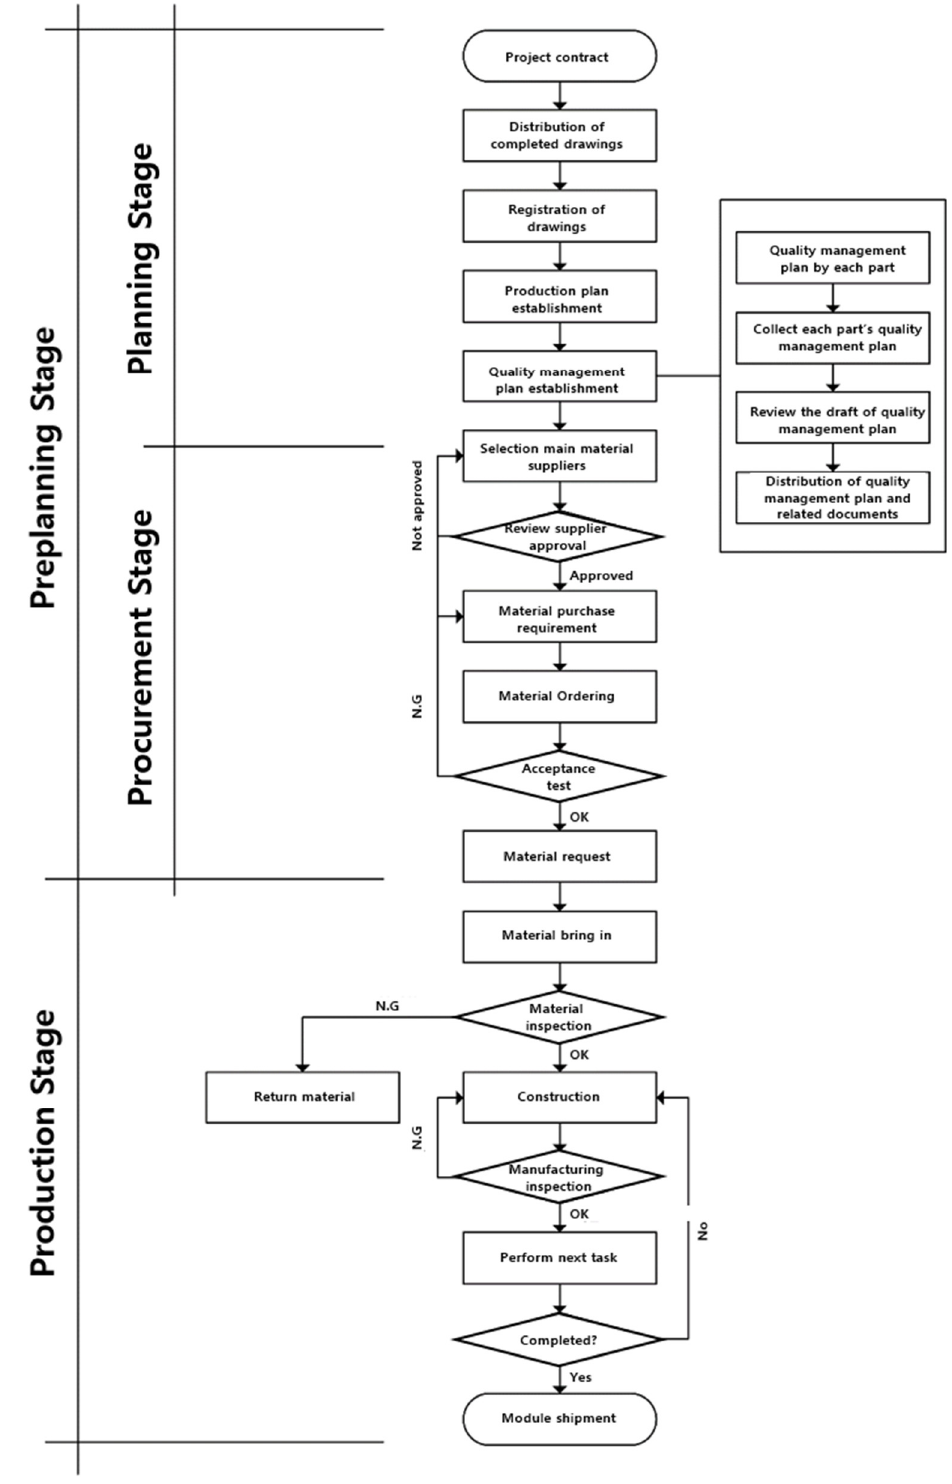
Figure 2. Quality management process in module